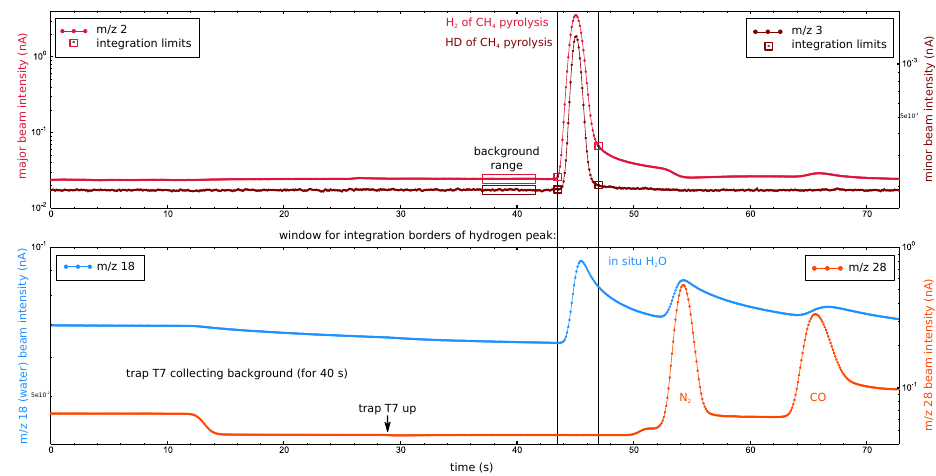
Figure 2. Chromatogram of signals induced by a pure CH 4 in He injection on logarithmic scales. Note that each beam is on its own scale. The top panel shows the hydrogen peak on m/z 2 and 3. The bottom panel displays the signals measured when the mass spectrometer is focussed to either m/z 18 (water) or m/z 28 (N 2 and CO). Clearly, N 2 and CO, which are trapped together with H 2 on T7, are well separated from H 2 by our cooled 2nd GC. A signal on m/z 18 (and 17, water), which is produced in situ in the mass spectrometer, is visible for H 2 , but also for N 2 and CO (compare text and Table 2). Individual backgrounds of the measured signals of 0.8, 0.0015, 0.2 and 0.2nA are subtracted for beams of m/z 2, 3, 18 and 28,